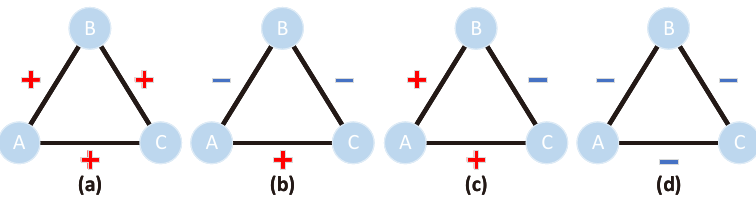
Figure 3. Examples of balanced and unbalanced triangles, where ( a , b ) are balanced triangles, and ( c , d ) are unbalanced